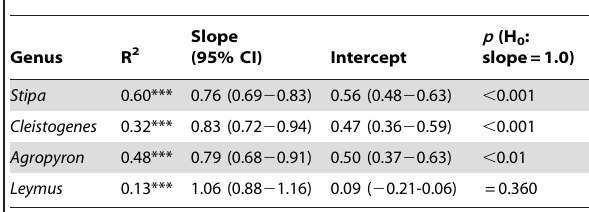
Table 6. Effects of PEI and DI on root/shoot ratios of four dominant genera ( Stipa , Cleistogenes , Agropyron , and Leymus) across a 2500-km long transect in northern China’s temperature